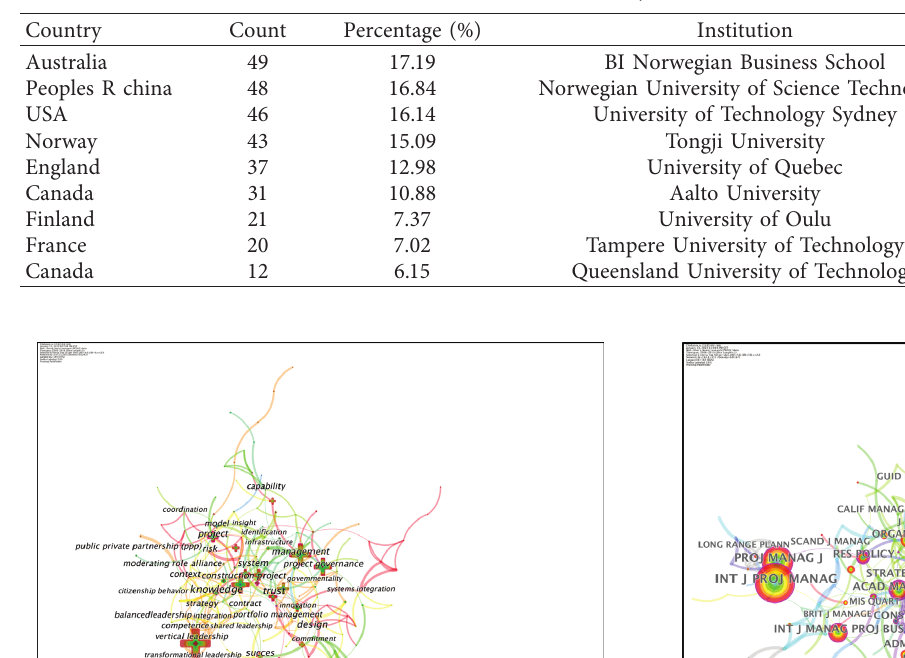
Table 2: Records ranked by countries and institutions.